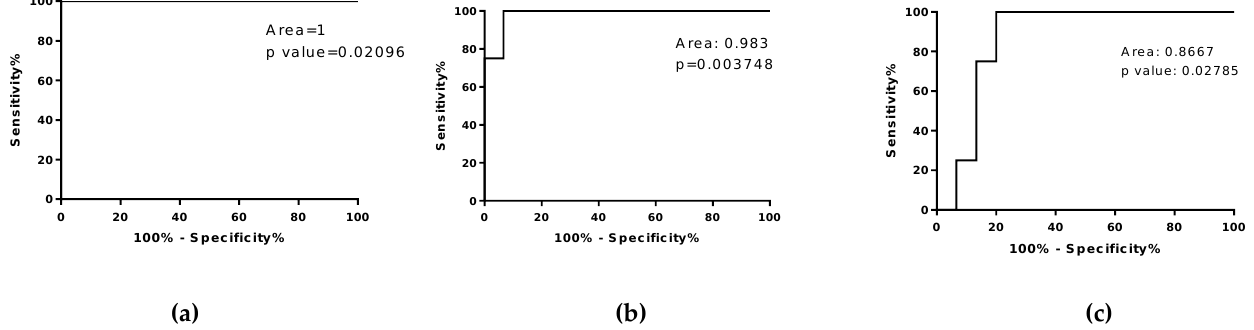
Figure 7. ROC curve analysis of mir-206 in fast and slow progressive SOD1 G93A mice and in WT re-innervating mice. ( a , b ) ROC curve analysis of miR-206 level in WT REN 30D compared to ( a ) SOD1 G93A low-copy mice at the late stage of the pathology and compared to ( b ) SOD1 G93A high-copy mice at end stage of the pathology. ( c ) ROC curve analysis of miR-206 level in SOD1 G93A high-copy mice compared to SOD1 G93A low-copy mice, respectively, at the end stage and late stage of the